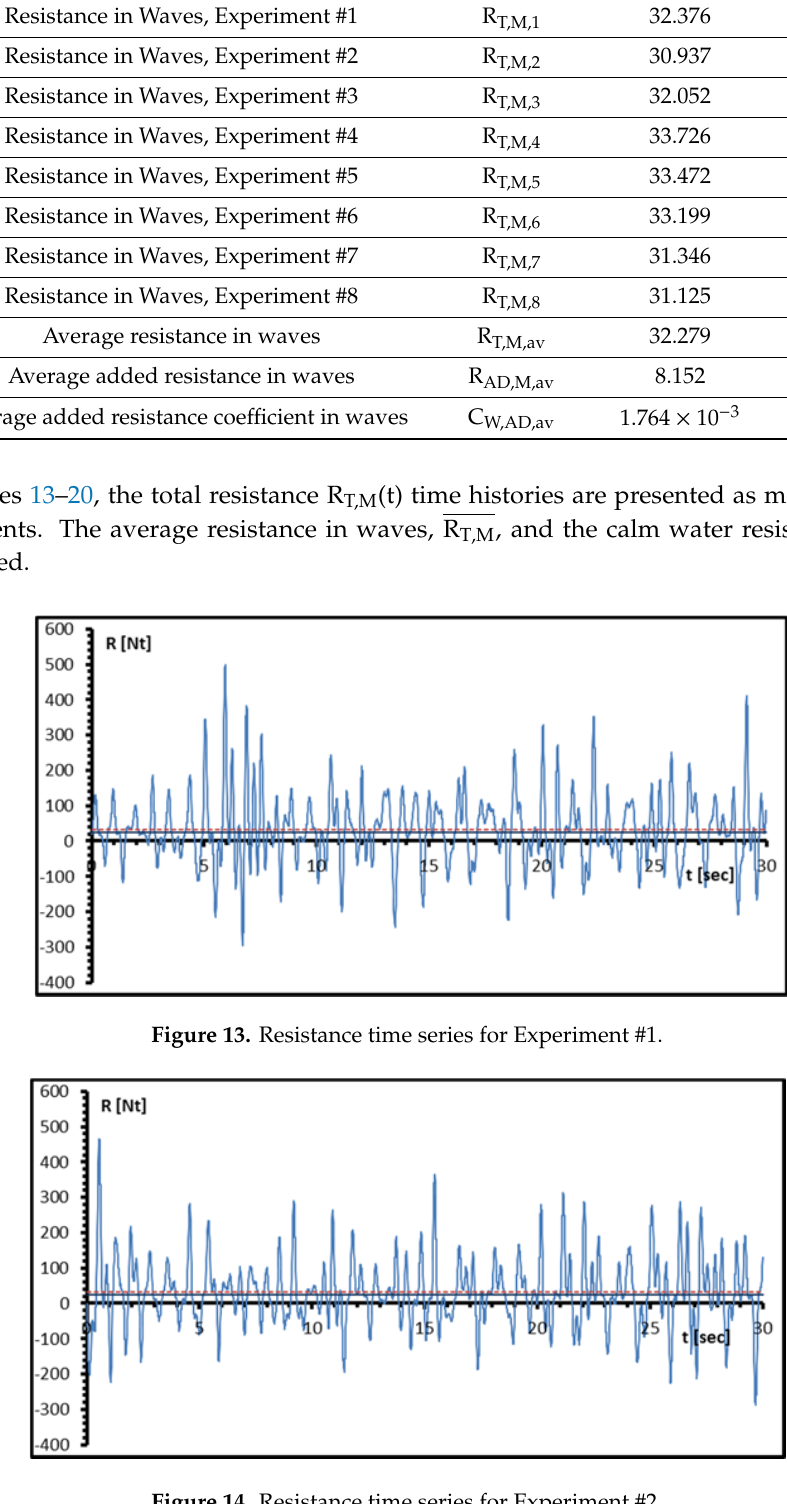
Figure 14. Resistance time series for Experiment #2.